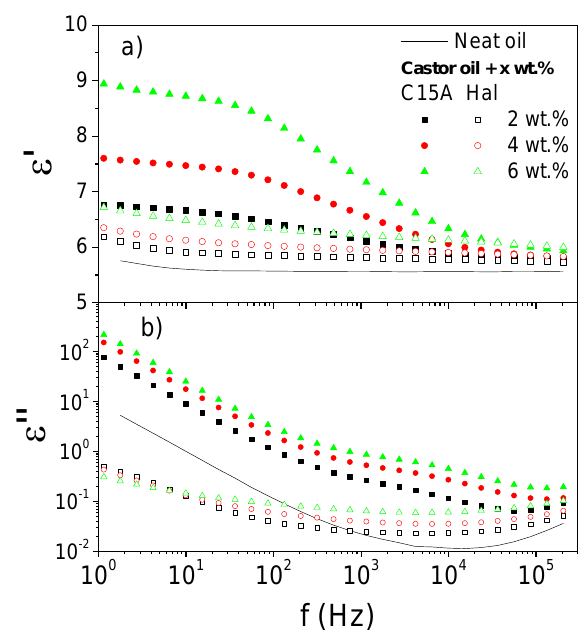
Figure 2. Frequency dependence of ( a ) the dielectric constant, ε´, and ( b ) the dielectric loss, ε´´, at 25 °C for Cloisite 15A and halloysite dispersions in castor oil, as a function of nanoclay concentration.